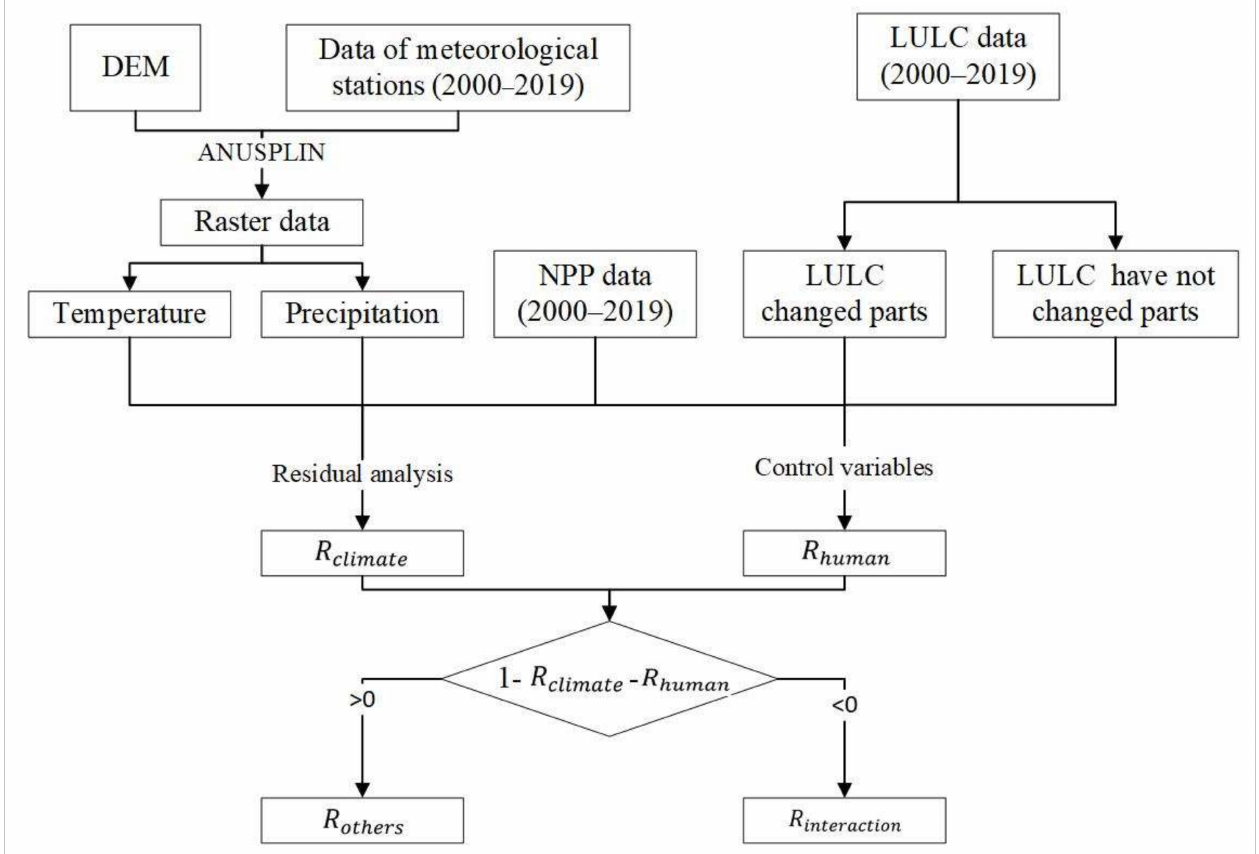
Figure 3. The flowchart of the RES-CON